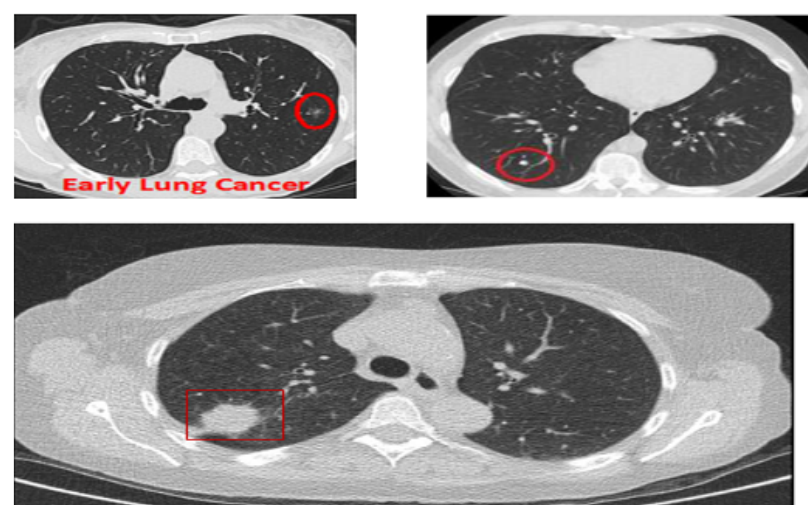
Figure 1. CT scans based on maximum intensity projection.